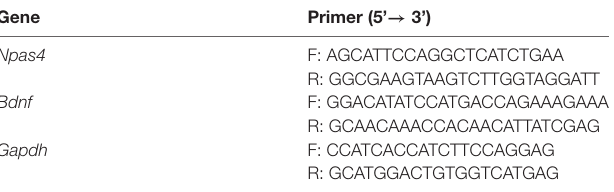
TABLE 1 | Primers used in gene expression